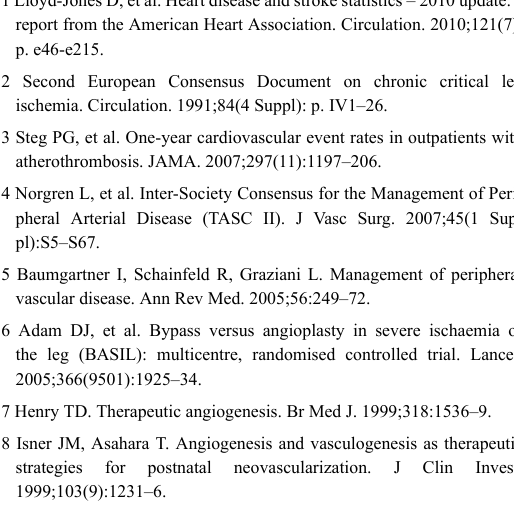
Figure 2 EPC-based cell therapy vs. secretome therapy. In conventional EPC-based cell therapy, EPC are generated from mononuclear cells isolated from the peripheral blood (PMBC) and used directly for transplantation via local (intramuscular) or systemic delivery (intra-arterial and intravenous) routes (A). To avoid immune rejection and achieve effective benefits, EPC therapy usually requires the use of a substantial amount of autologous cells. Alternatively, these ex vivo - derived early EPC can be subjected to hypoxic